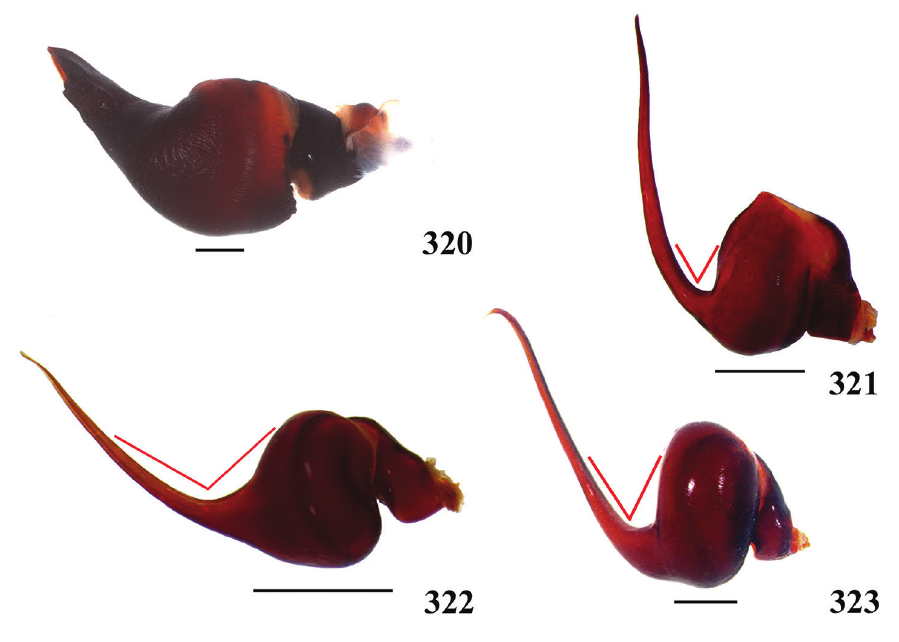
Figure 320–323. Male palpal bulb characters. 320 Lasiodora sp., retrolateral, left palp 321–323 an- gle between medial portion of embolus and tegulum’s margin in retrolateral view 321 Pachistopelma bromelicola , right palp, very acute angle 322 Iridopelma hirsutum (IBSP 8077), right palp, obtuse angle 323 Avicularia avicularia , right palp, acute angle (MNRJ 13659A). Scale bars = 1 mm. Red bars show angle between tegulum’s margin and embolus medial